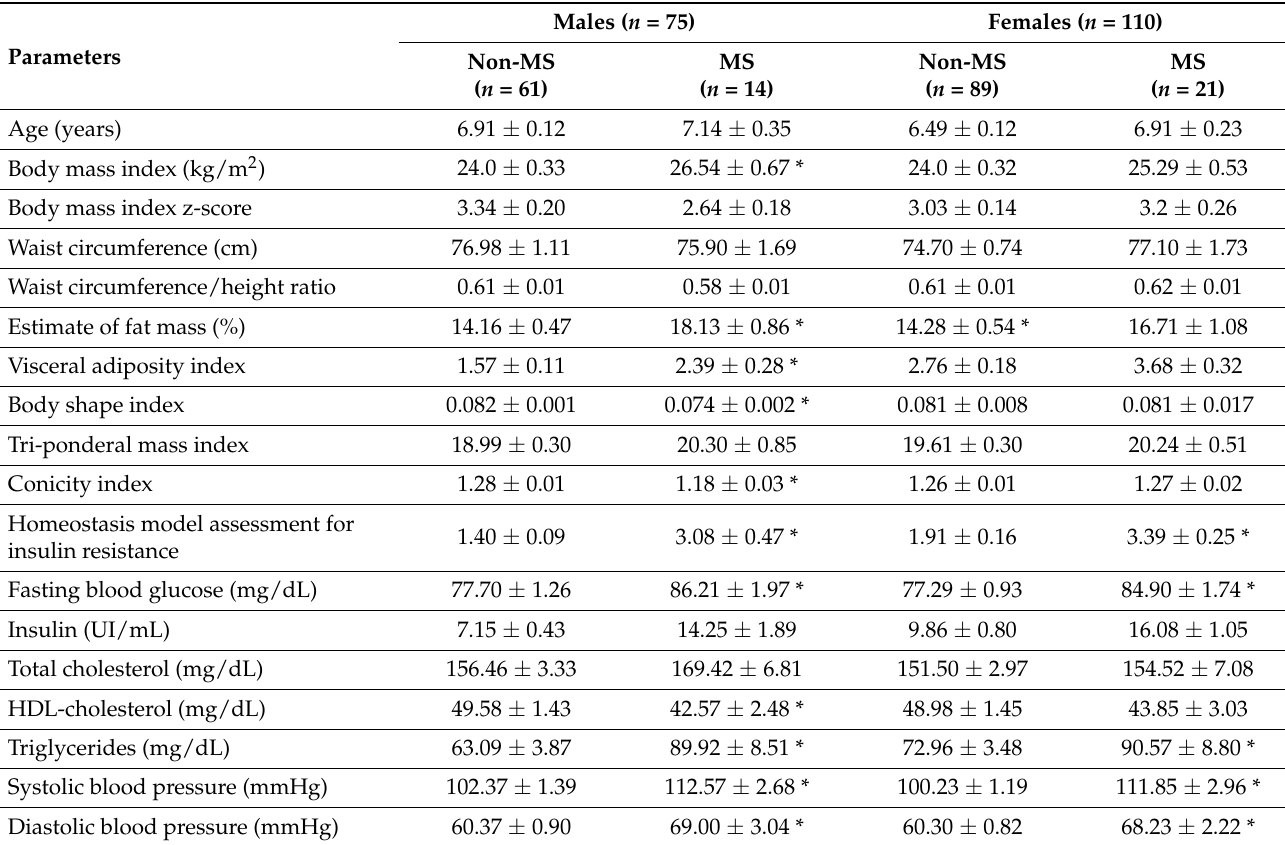
Table 2. Clinical and biochemical data in males and females with or without metabolic syndrome